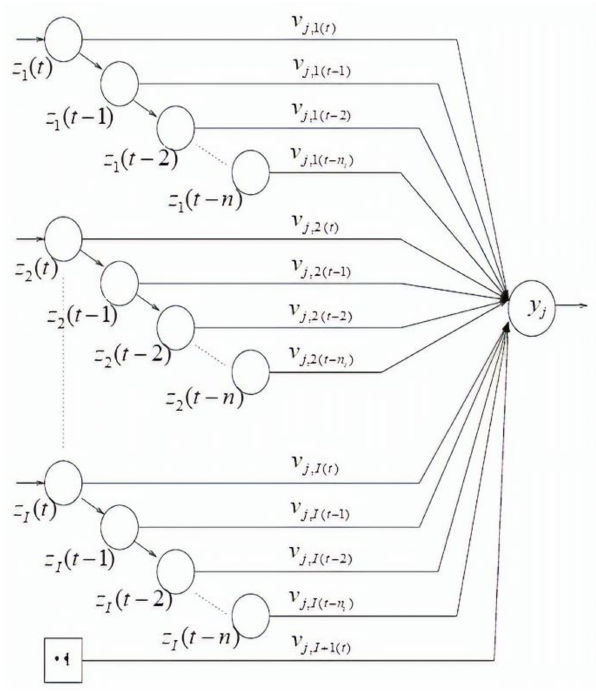
Figure 2. A single time delay neuron.